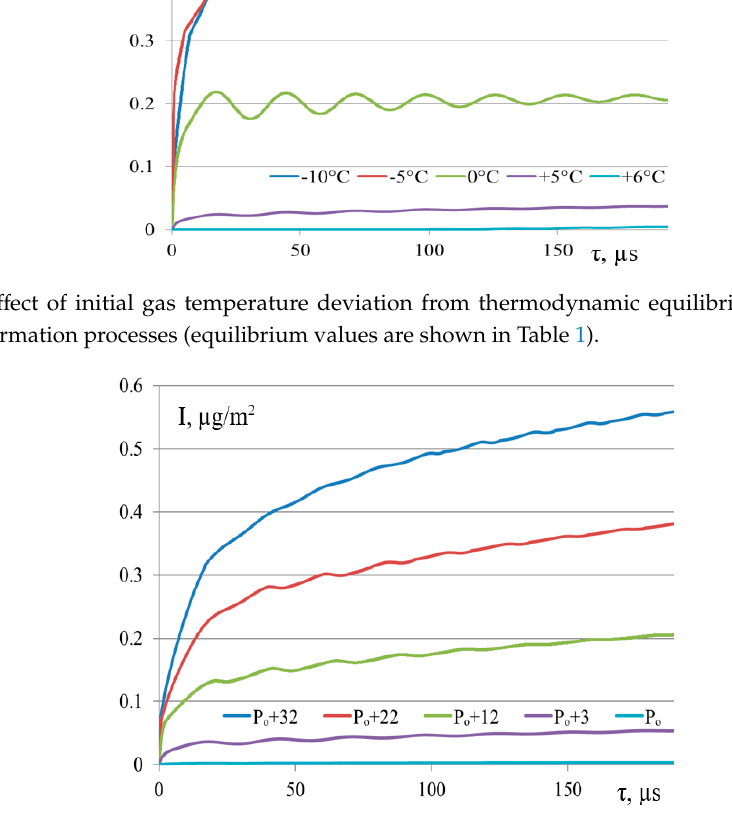
Figure 10. The speed of wall motion of the methane bubble at different pressures, 10 5 Pa.